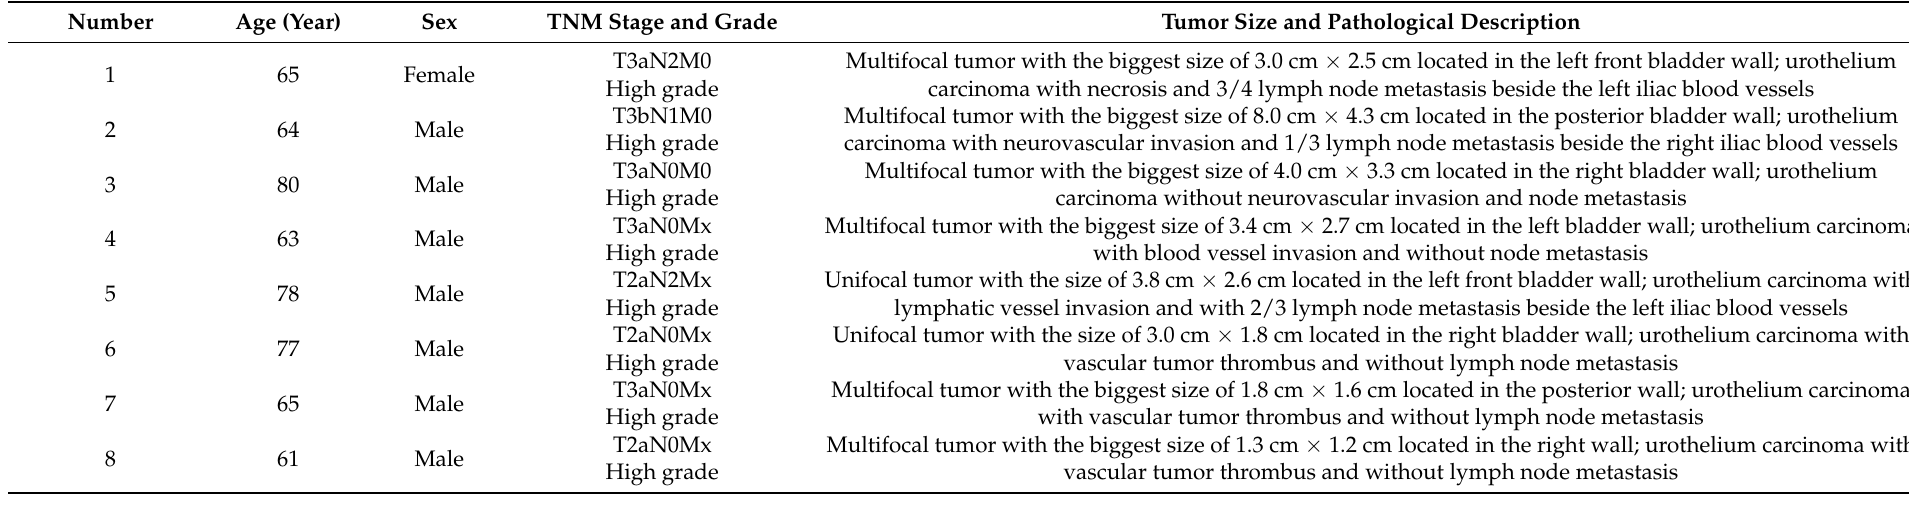
Table 1. Patient and tumor